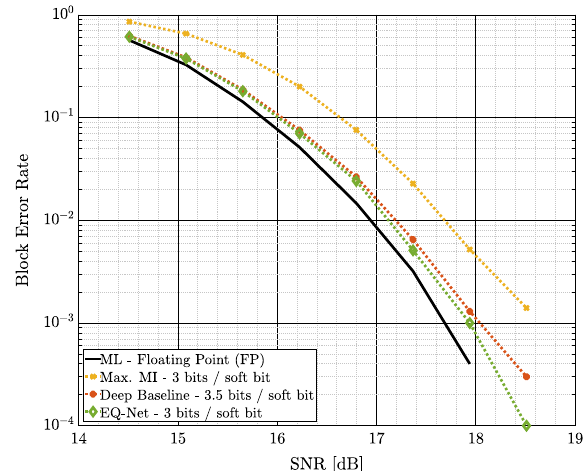
Fig. 9 Quantization performance of EQ-Net evaluated against state-of-the-art methods in 2 × 2 , 64-QAM, i.i.d. Rayleigh fading, and LDPC-coded with size (324,